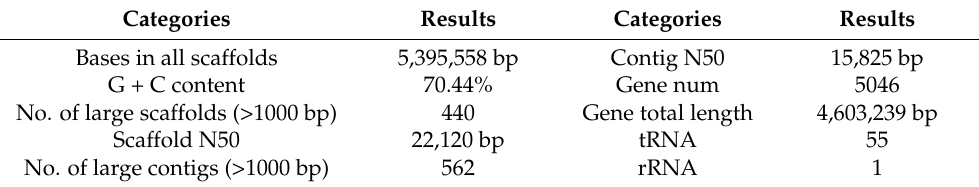
Table 2. Genome information of strain